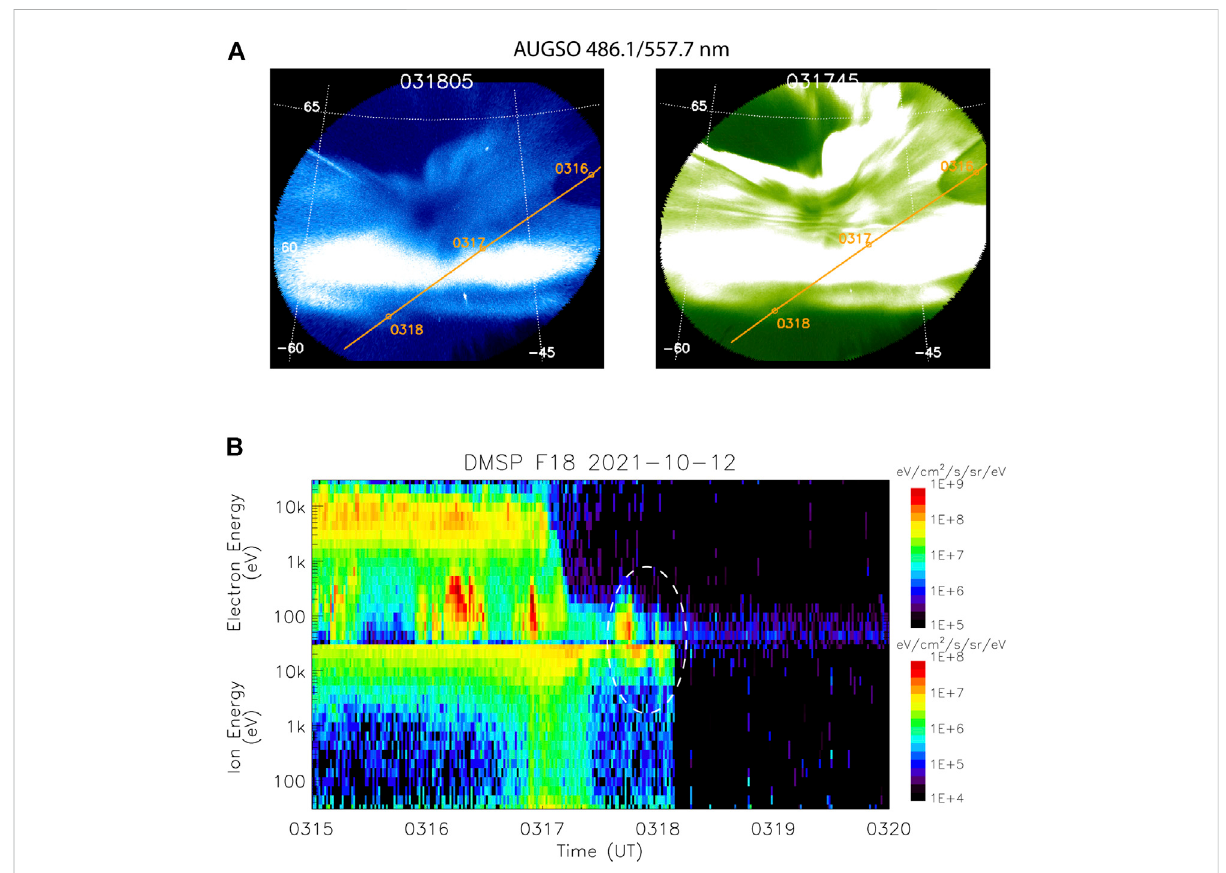
FIGURE 3 (A) AUGSO 486.1 and 557.7 nm images with the trajectory of the norther conjugate footprints of DMSP F18 satellite overplotted. An emission altitude of 135 km is assumed. (B) The electron energy fl ux spectrogram (upper panel) and ion energy fl ux spectrogram (bottom panel) measured by DMSP F18 SSJ. A dashed oval highlights the potential correspondence with the